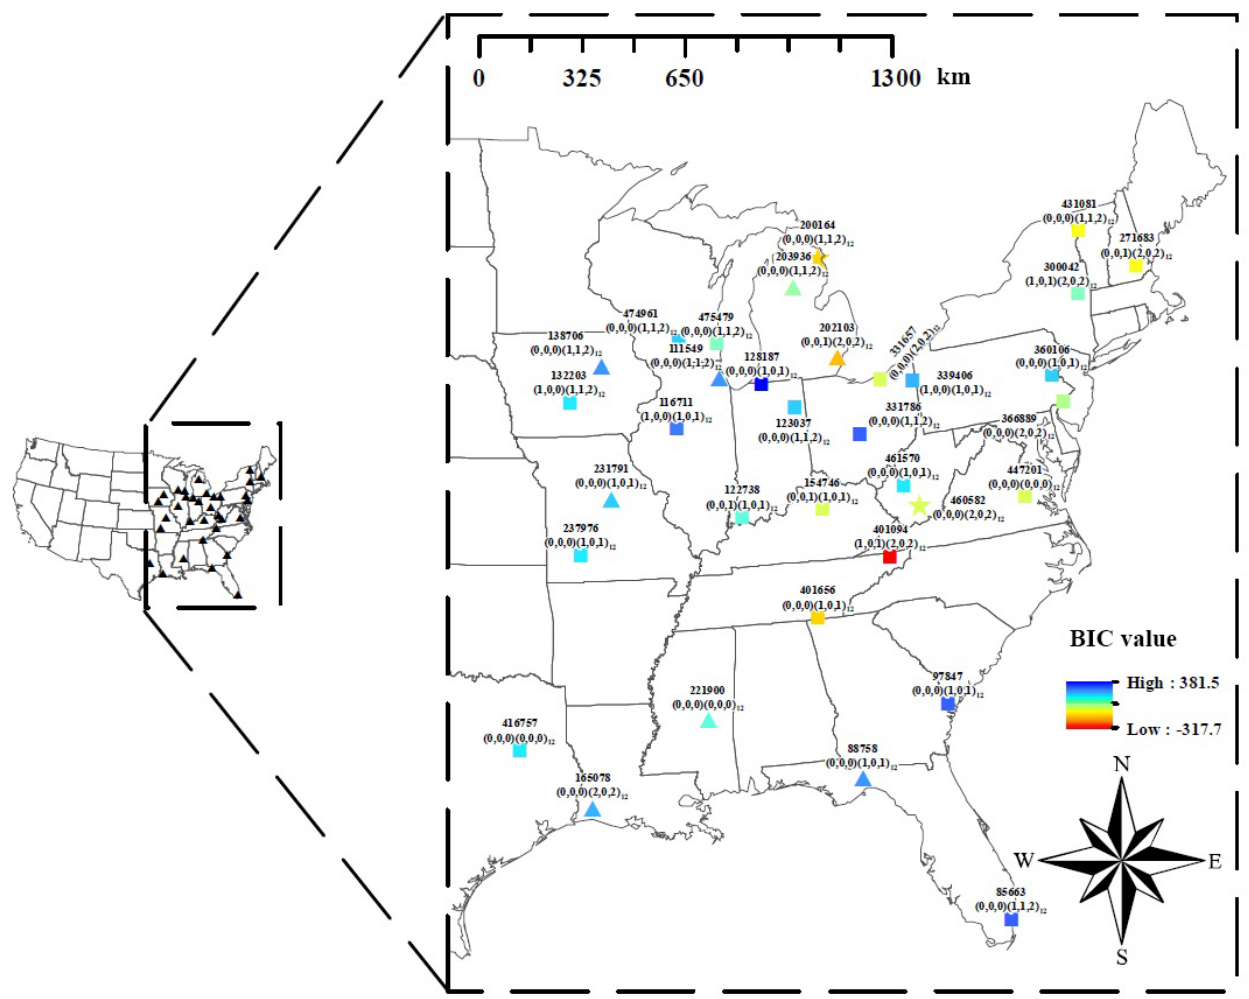
Figure 3. Study area and 34 NCDC hourly rainfall gauges. The label of the markers is presented in the following format: xxxxxx( i, j, k )( x, y, z ) 12 , where xxxxxx represents the NCDC gauge ID; ( i, j, k ) represent the orders of the autoregressive, differencing, and moving average terms of the SARIMA model; and ( x, y, z ) represent the orders of the seasonal autoregressive, differencing, and moving average terms of SARIMA model. The colour of the markers represent the Bayesian information criterion (BIC) value of the SARIMA model. The lower BIC indicates more parsimonious parameterization, larger likelihood, or both. Model description of SARIMA is detailed in Sect.